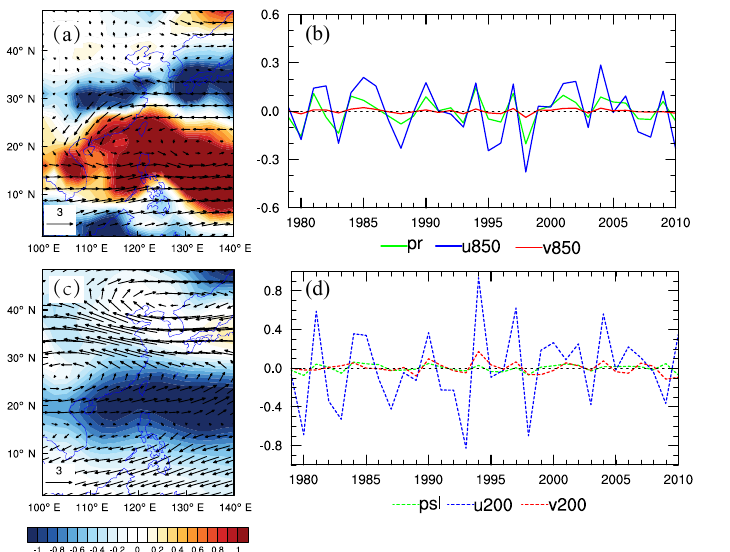
Figure 4. Spatial distribution of the first leading EOF mode of June–July–August precipitation and winds over 850hPa (a) , mean sea level pressure and winds over 200hPa (c) , and the associated principal component (PC; b, d ). The GPCP and the ERA-Interim data from 1979–2005 are used for the EOF analysis in the EASM domain.